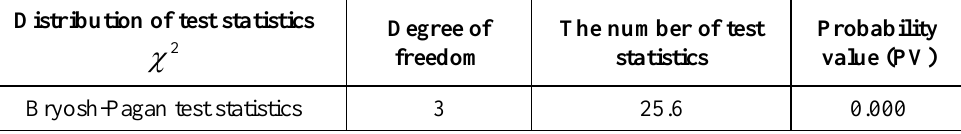
Table7. Simultaneous correlation test between LM test